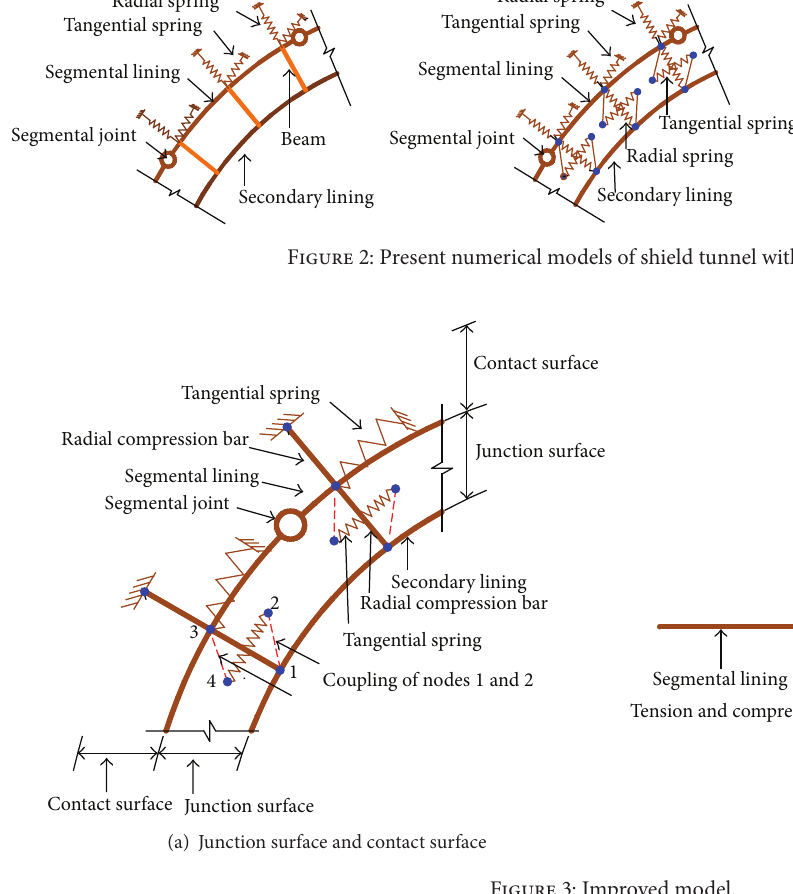
Figure 3: Improved